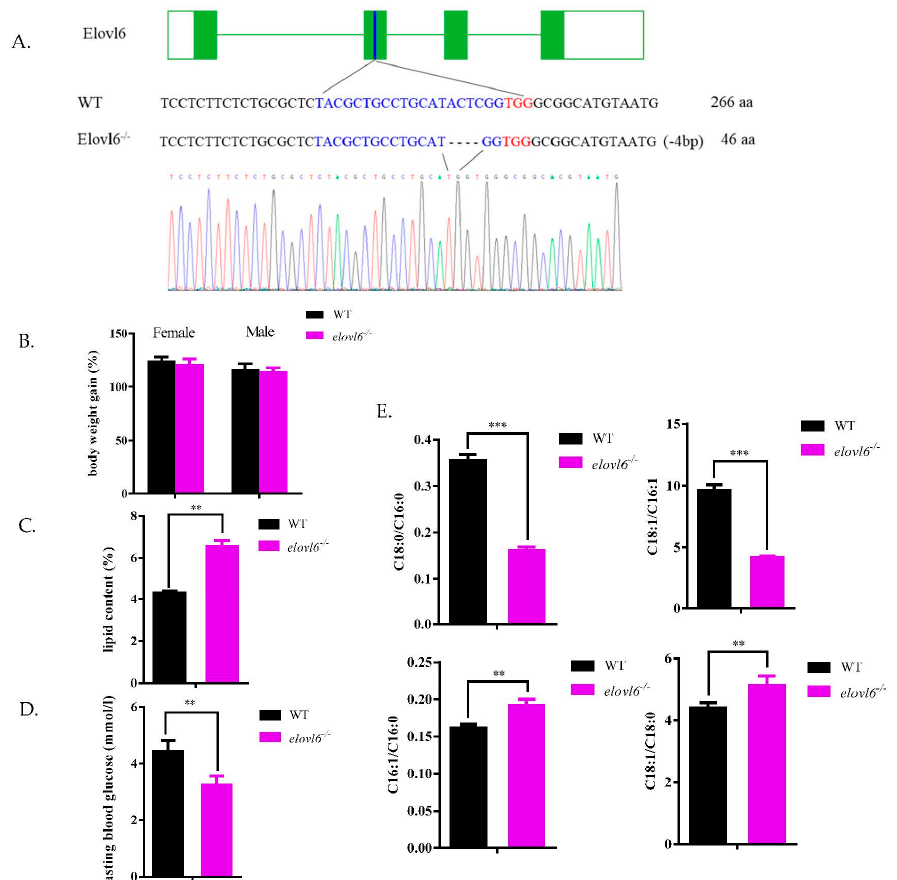
Figure 1. Targeting of the elovl6 and changes in lipid / glucose metabolic features between wild type zebrafish (WT) and elovl6 − / − zebrafish. ( A ) Targeting of the elovl6 in WT and elovl6 − / − zebrafish. The obtained elovl6 − / − zebrafish lacked 4 bp bases, causing protein translation to stop prematurely. Introns were green lines, exons green squares and the target site blue square. ( B ) Body weight gains of WT and elovl6 − / − zebrafish females / males (the ratio of the weight of two-month-old fish to the weight of one-month-old fish,%; n = 4). ( C ) The whole-body lipid contents of WT and elovl6 − / − zebrafish ( n = 4). ( D ) Fasting blood glucose contents of WT and elovl6 − / − zebrafish ( n = 3). ( E ) The ratios of C18:0 to C16:0, C18:1 to C16:1, 18:1 to 18:0 and 16:1 to 16:0 in whole bodies of WT and elovl6 − / − zebrafish ( n =